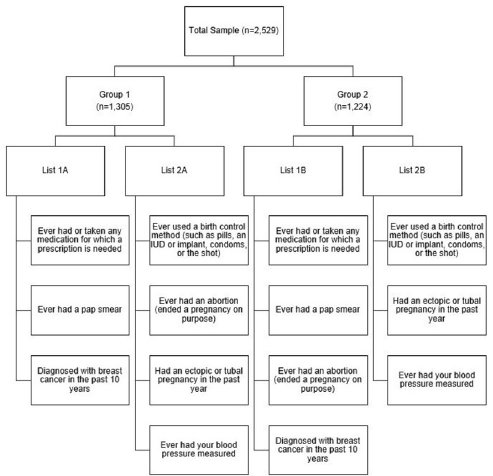
Fig 1. Schematic of the double list experiment to measure abortion utilization in the Ohio Survey of Women (n = 2,529).